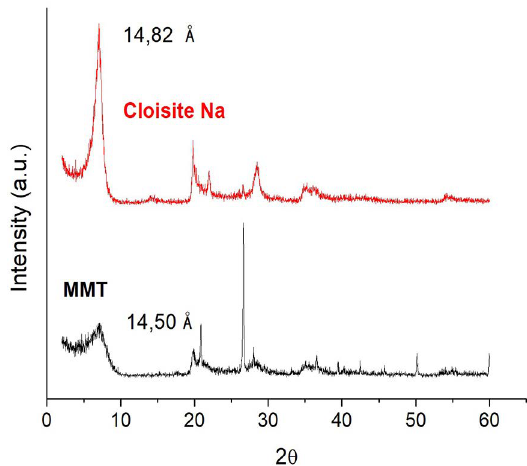
Figure 3. X-ray diffraction patterns of the Brasgel PA and Cloisite Na